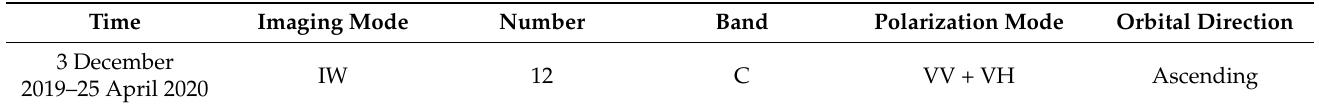
Table 2. Sentinel-1A data parameters.